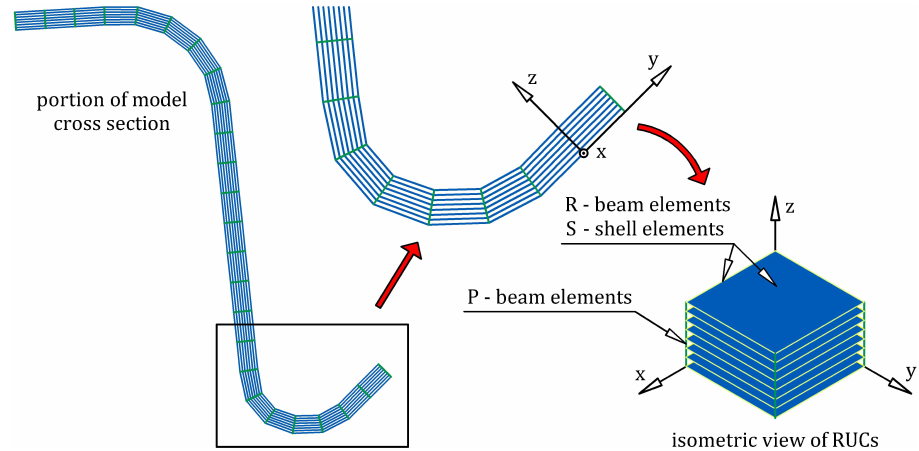
Figure 8: The layered structure of the mesoscale model generated using the developed preprocessor.